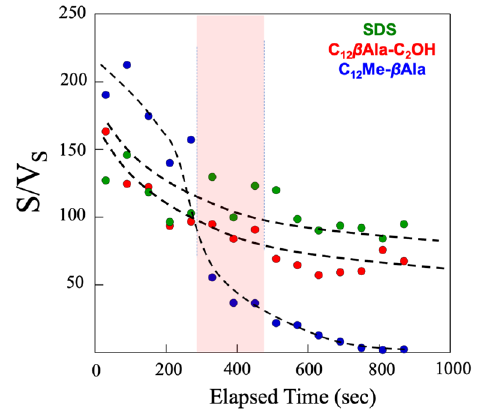
Figure 15. Specific surface area (S/V S ) determined at a 140 mm height as a function of the elapsed time after foaming for SDS (green), C 12 –EtOH– β Ala (red), and C 12 –Me– β Ala (blue). The time domain at 300 – 480 s is indicated in red. Broken lines are guides for the eye.